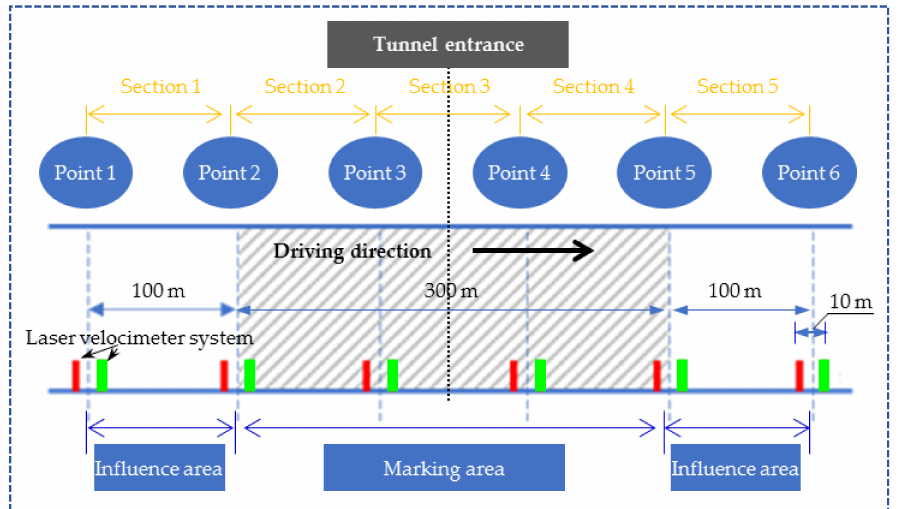
Figure 7. Assessing vehicle speeds controlled by